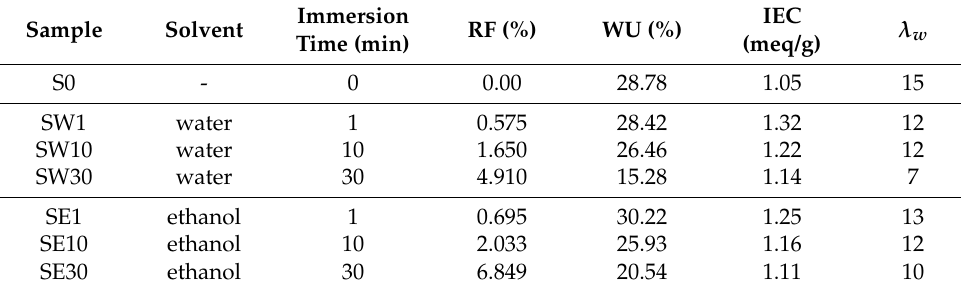
Table 3. PFSA–RF-modified membrane characteristics.